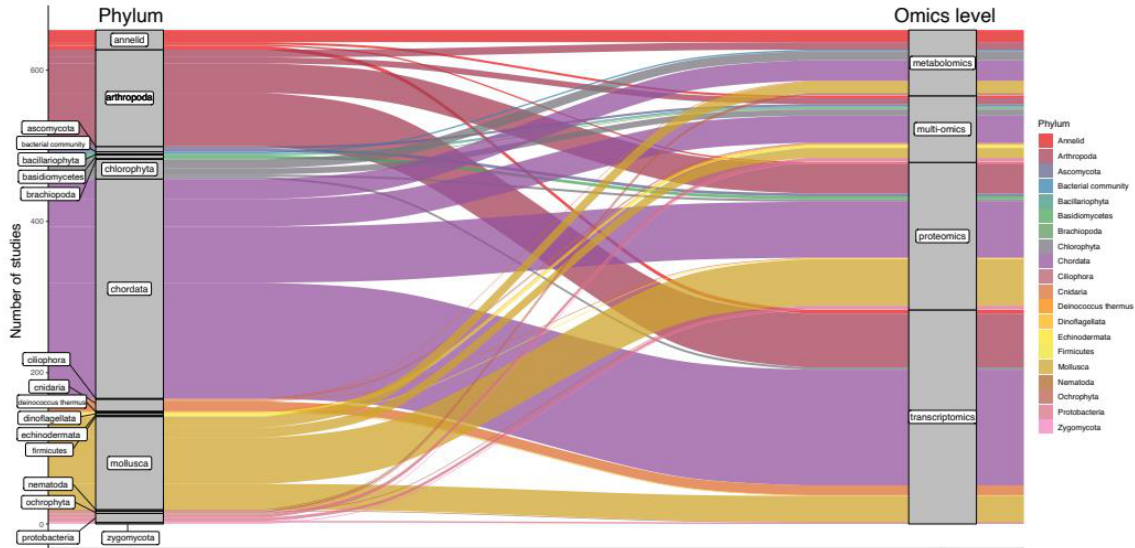
Figure 2. Alluvial diagram depicting the relative frequencies of phyla (left blocks) for which data on different omics levels (right blocks) have been generated between 2000 and 2020. Stream fields between the blocks are color coded based on taxonomic affiliation and represent the total number of times specific omics methods have been applied within the specified phyla.